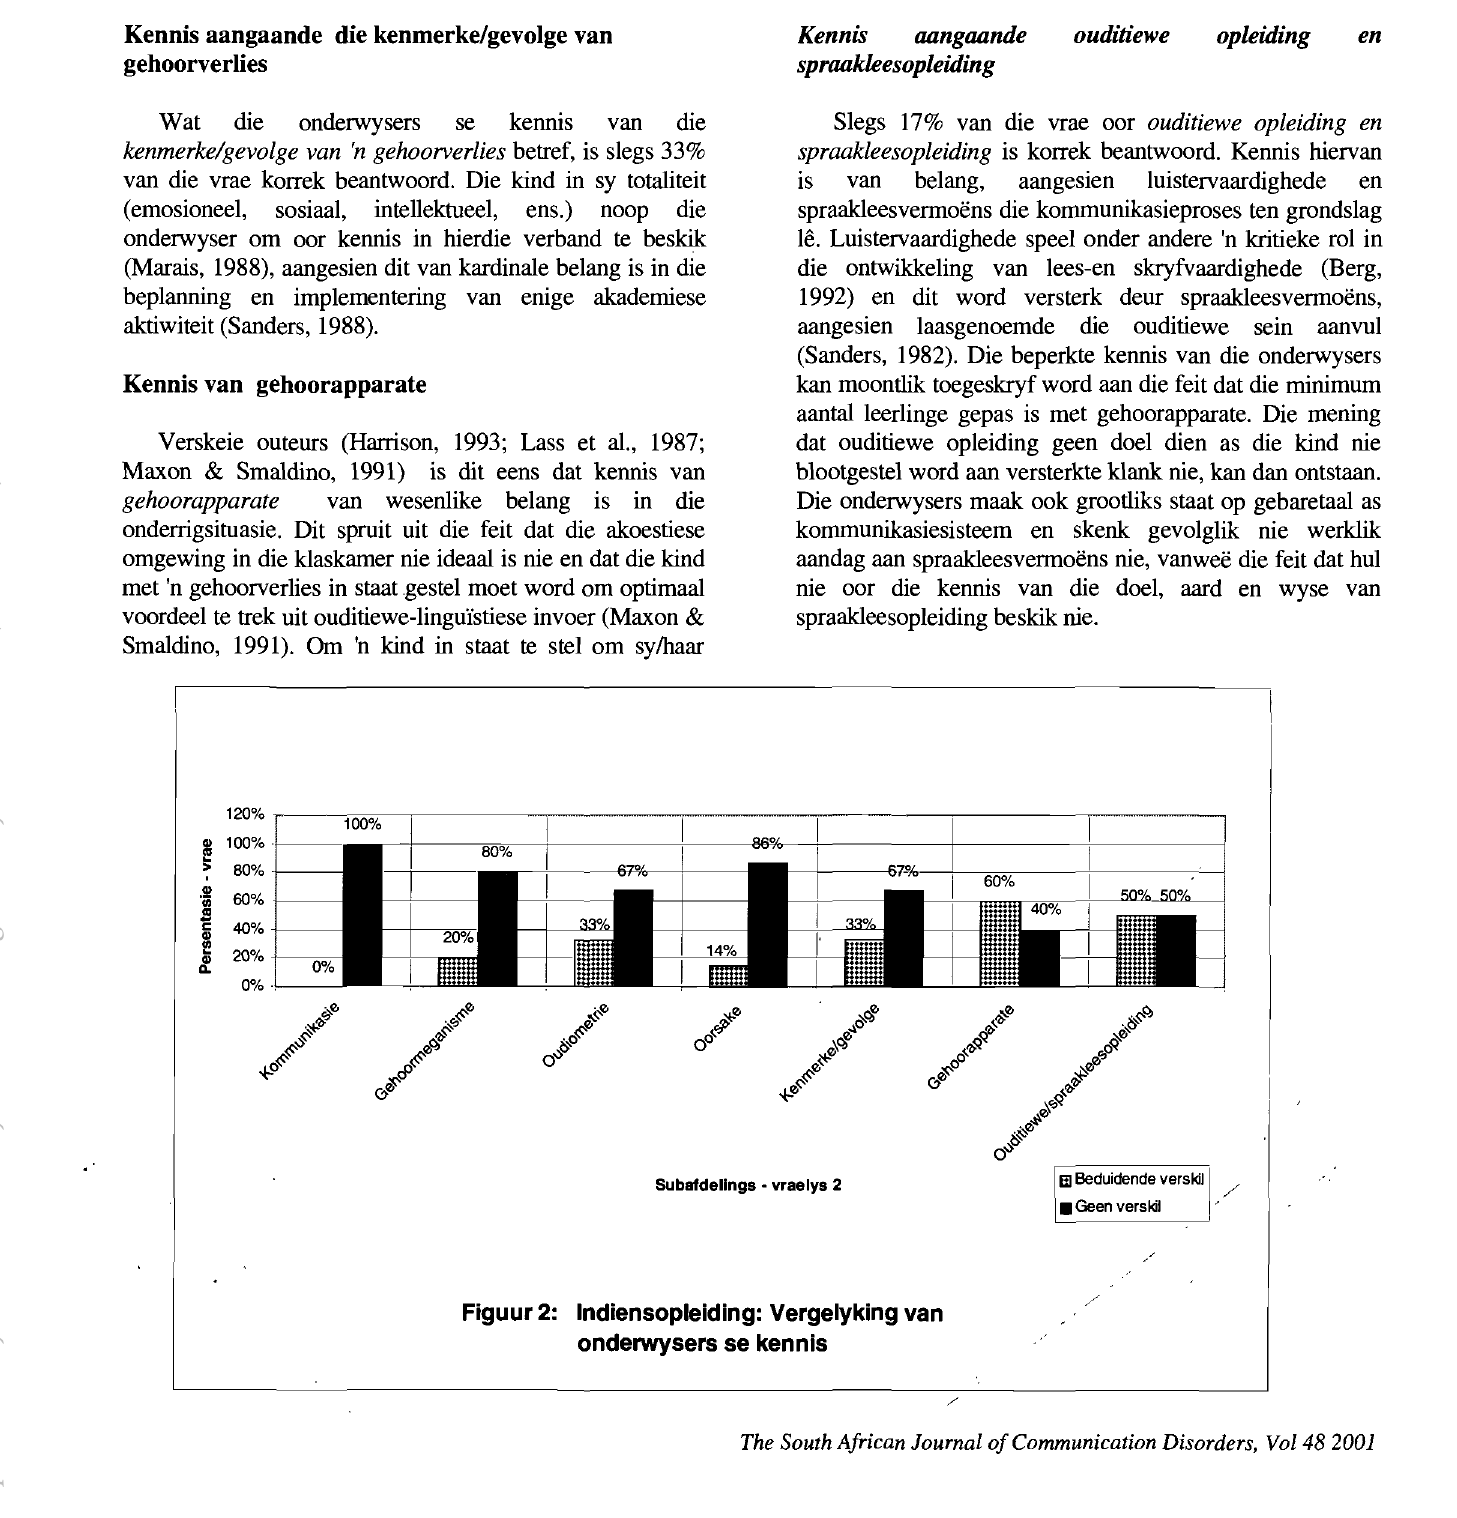
Figuur 2: Indiensopleiding: Vergelyking van onderwysers se kennis